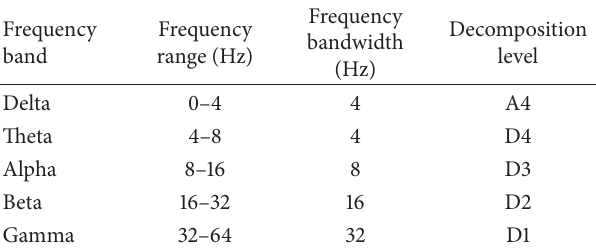
Table 2: EEG signal